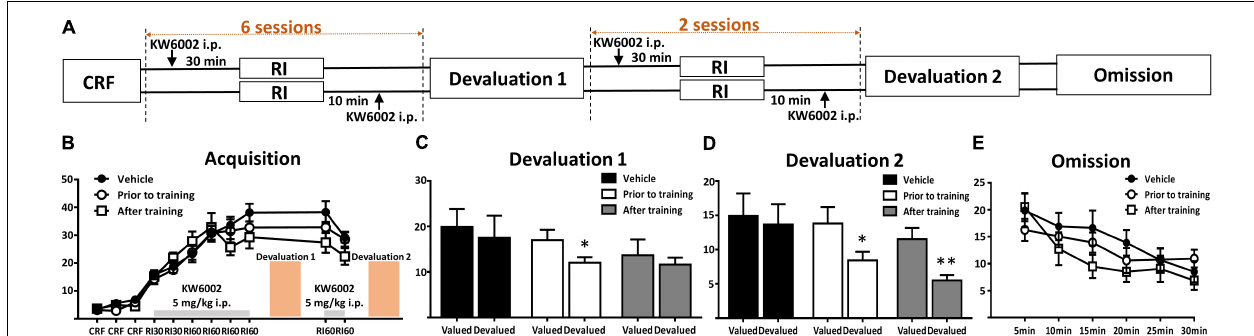
FIGURE 2 | Pharmacological blockade of A 2A Rs prior to and post daily training session promoted goal-directed seeking but not acquisition of instrumental conditioning. (A) Experimental design schematic with KW6002 injected intraperitoneally prior to and post-training. (B) There was no significant difference in acquisition of instrumental learning among these groups for lack of between groups effect ( p = 0.593) and training X drug administration groups interaction effect ( p = 0.108). (C) In the first devaluation test, mice with KW6002 injected prior to training showed sensitive to outcome devaluation ( p = 0.021, ∗ p < 0.05), compared to vehicle ( p = 0.223) and that with KW6002 treated post-training ( p = 0.539). (D) Then after two additional days of RI60 training, whatever KW6002 administered prior to ( p = 0.034, ∗ p < 0.05) or post ( p = 0.008, ∗∗ p < 0.01) training, mice displayed sensitive to outcome devaluation in the second devaluation test compared to the vehicle group ( p = 0.482). (E) All mice decreased their lever presses indistinctively in the omission test in which the action-outcome contingency was reversed, showing neither testing time X drug administration groups interaction effect ( p = 0.359) nor between-subject effect of drug administered groups ( p = 0.836). All data was analyzed by two-way ANOVA for repeated measurement, followed by post hoc comparison with Bonferroni test ( n = 8/group).